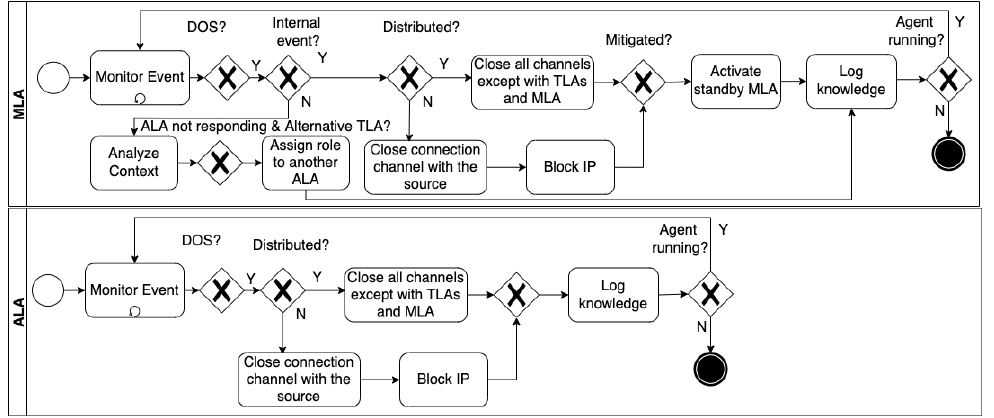
Figure 10. The adaptation process to a denial-of-service